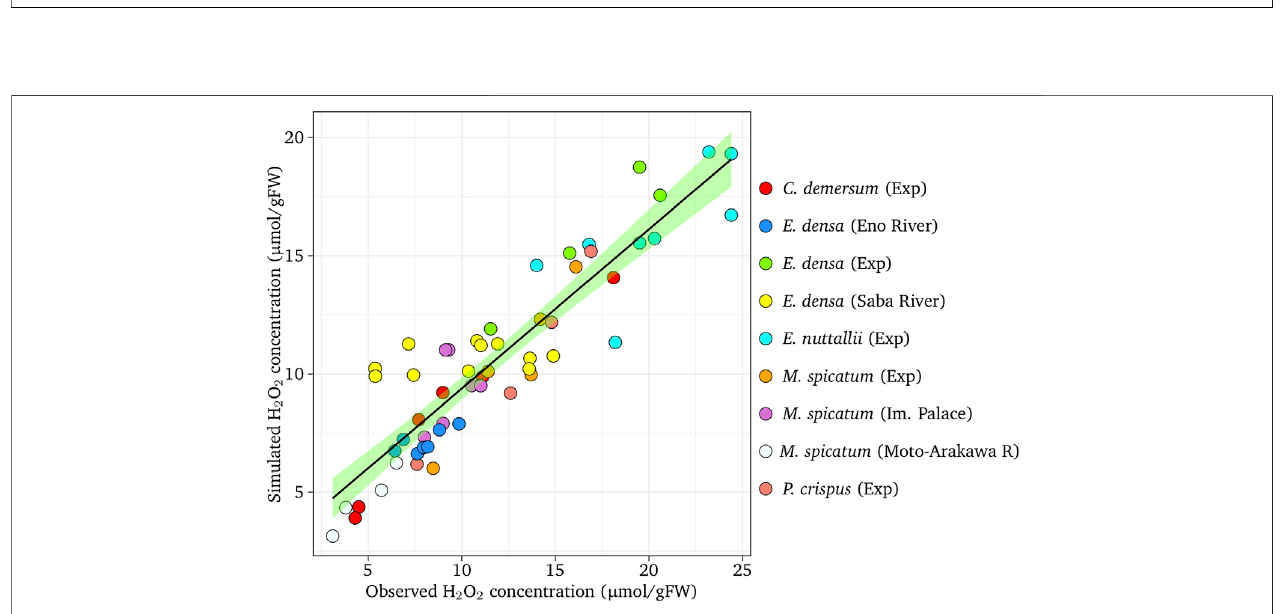
FIGURE 5 | The comparison of simulated H 2 O 2 concentration with observed H 2 O 2 concentration. The dashed line indicates the perfect agreement. The shaded band (green) represents the 95% con fi dence interval on the fi tted values.